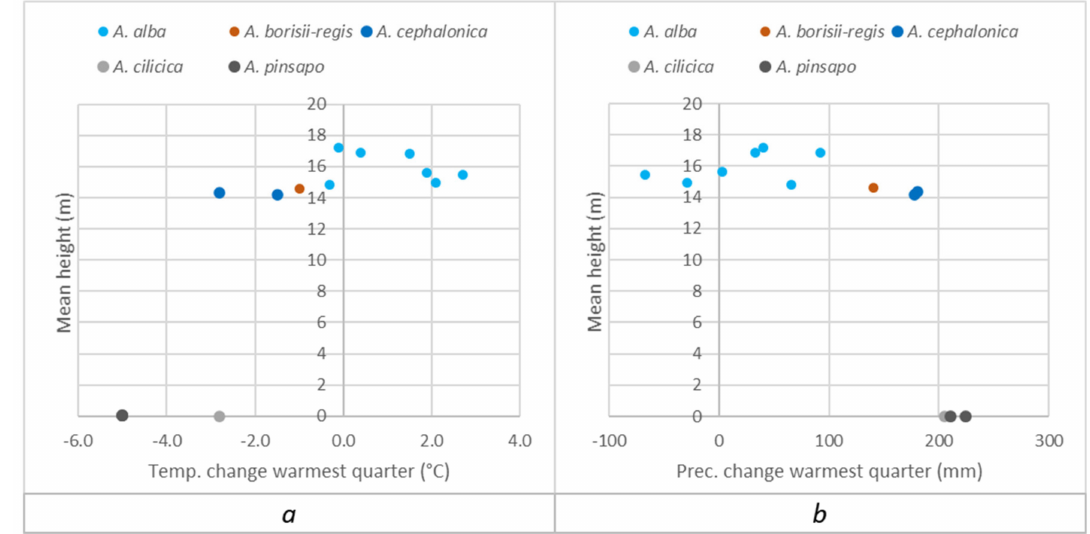
Figure A1. Mean summer temperature ( a ) and precipitation ( b ) change versus mean height of silver fir (blue), A. cephalonica (red) and A. borisii-regis (deep blue) provenances at the age of 40 years, in the trial 64, P í sek. The Mediterranean provenances of A. cilicica and A. pinsapo (gray) suffered total mortality, depicted at 0